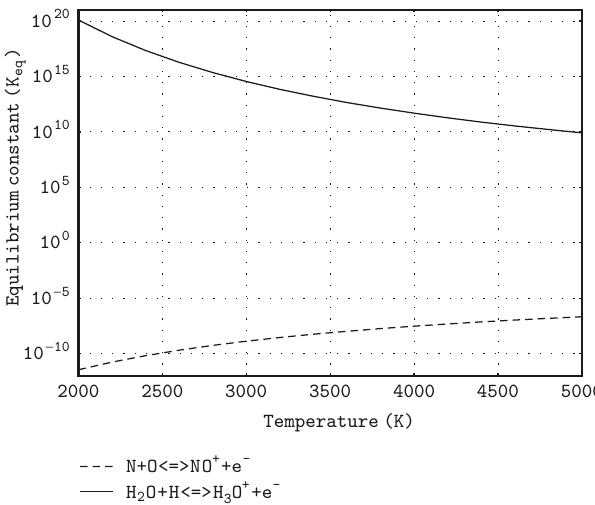
Figure 3: Effect of electron temperature (T constants of H 3 O + and NO + .